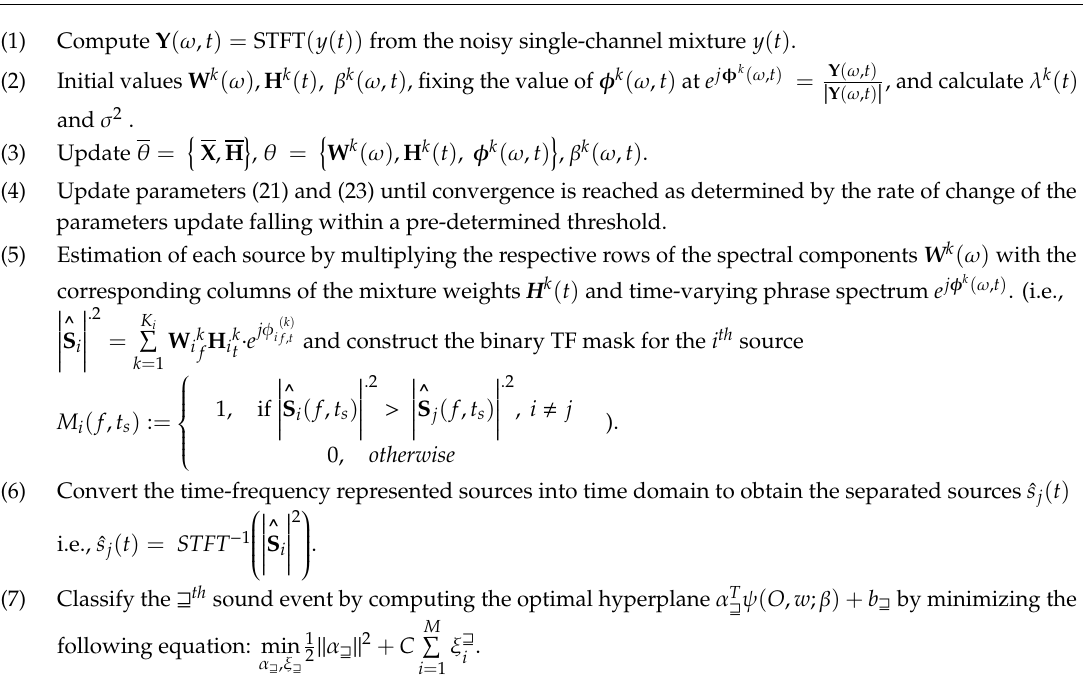
Algorithm 1 Overview of the proposed